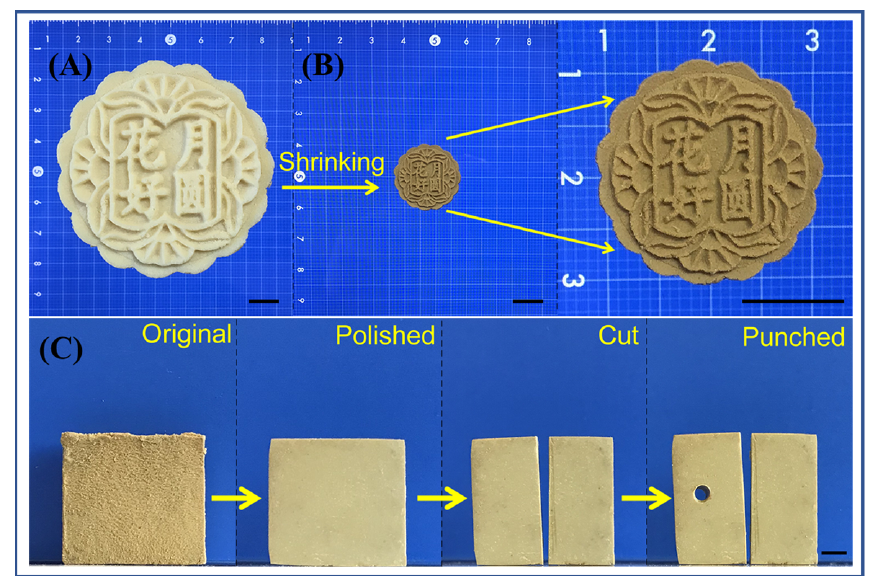
Figure 9. ( A ) PANF hydrogel in the shape of a mooncake; scale bar: 10 mm [43]. ( B ) PANF bulk in the shape of a mooncake; scale bar: 10 mm [43]. ( C ) Typical postprocessing approaches (polishing, cutting and punching) of PANF bulk; scale bar: 4 mm [43]. Copyright 2021 John Wiley and Sons.